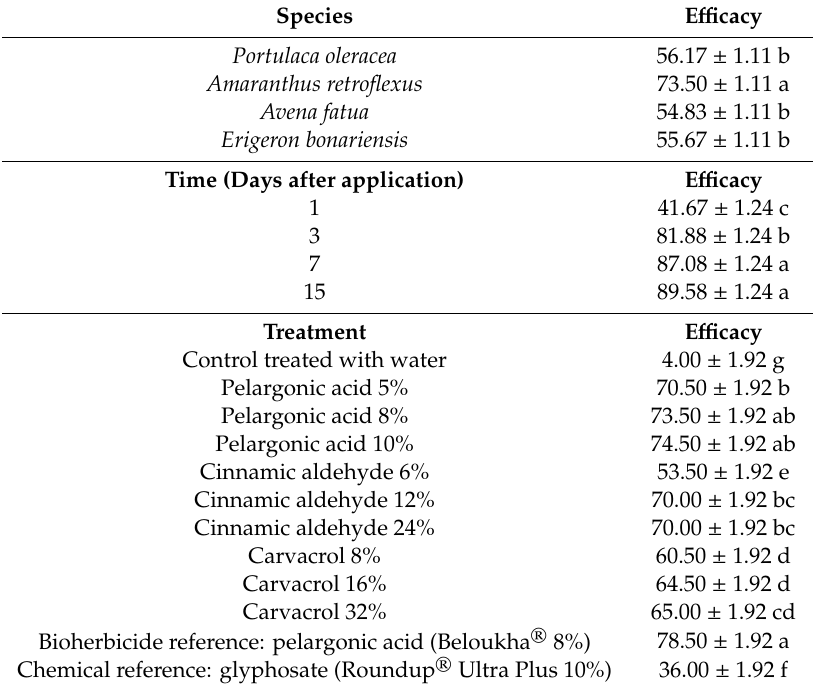
Table 5. E ffi cacy according to the species, time, and